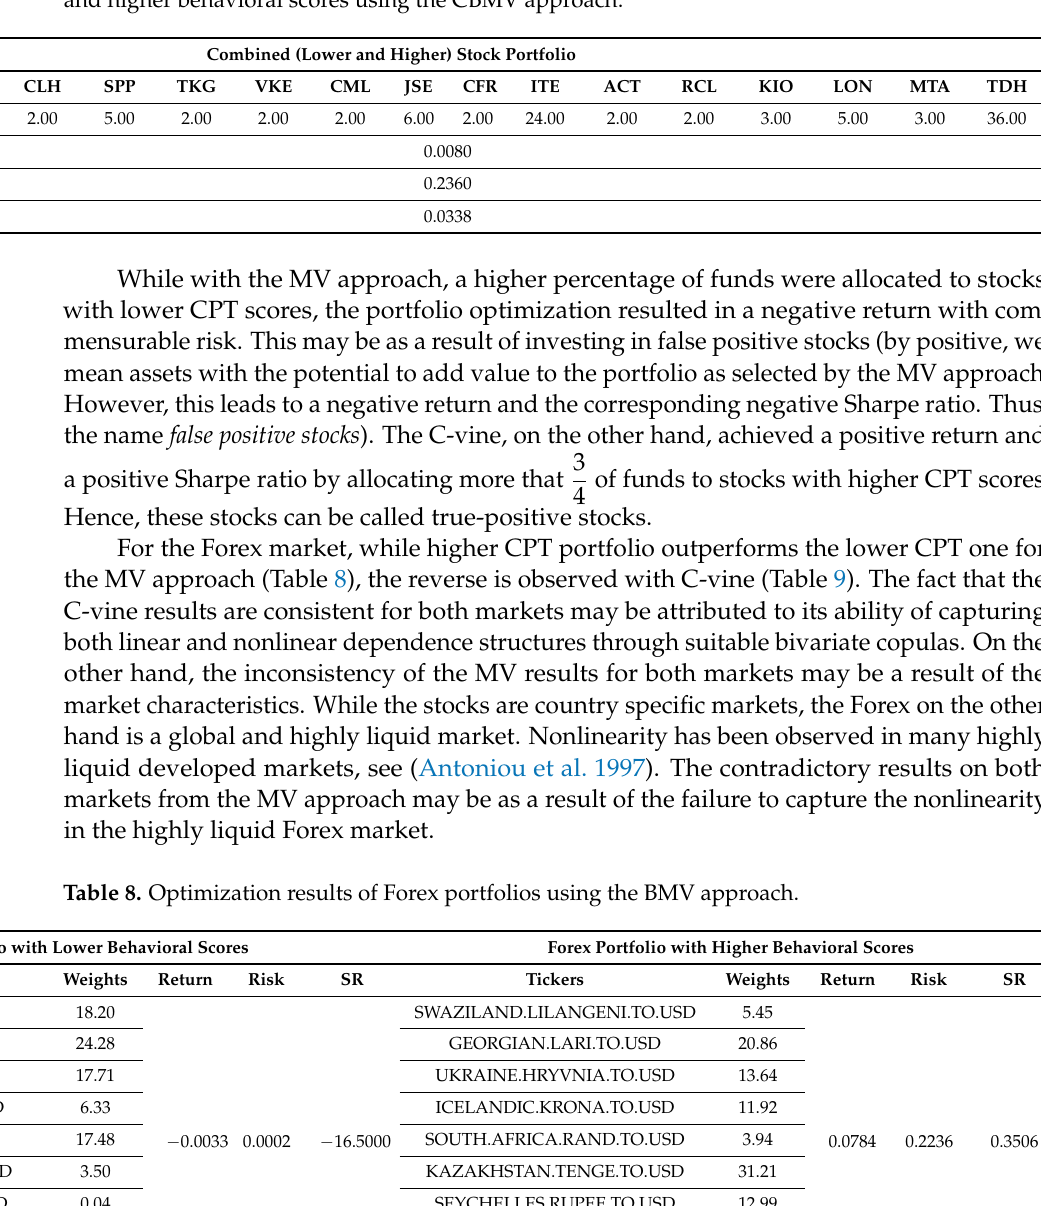
Table 7. Optimization results of the portfolio consisting of a combination of JSE stocks with lower and higher behavioral scores using the CBMV approach.